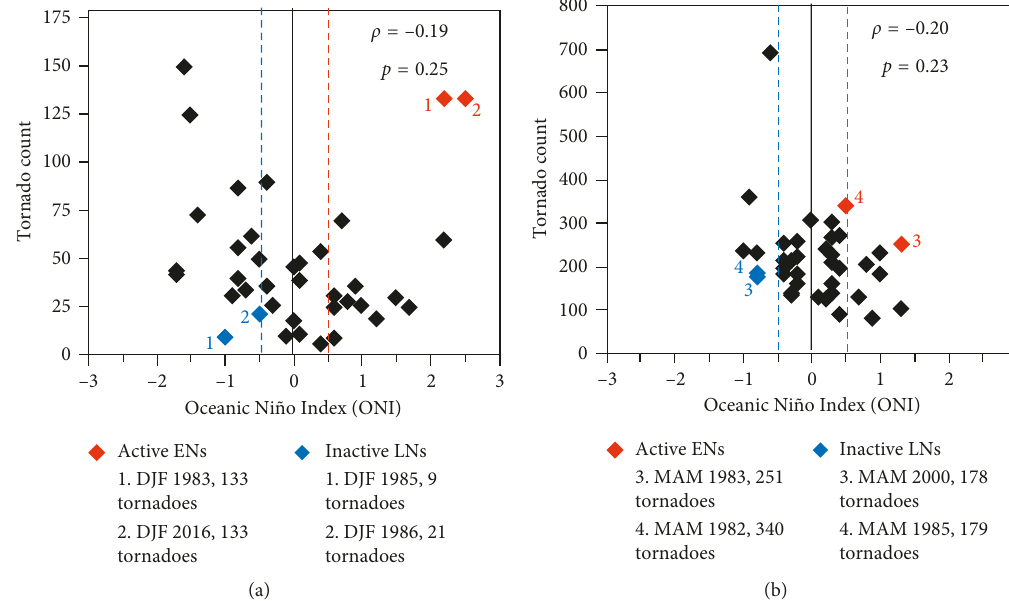
Figure 1: Number of E(F)1+ tornadoes in (a) DJF and (b) MAM and the concurrent Oceanic Niño Index (ONI). Vertical dashed blue and red lines are placed at ONI 0.5 and 0.5 and demarcate LN and EN, respectively. The blue and red diamonds represent the two most (cid:31) inactive and active LNs and ENs, respectively. Spearman’s ρ rank correlation coefficients and p values are provided in the top-right corners of the graphs. −